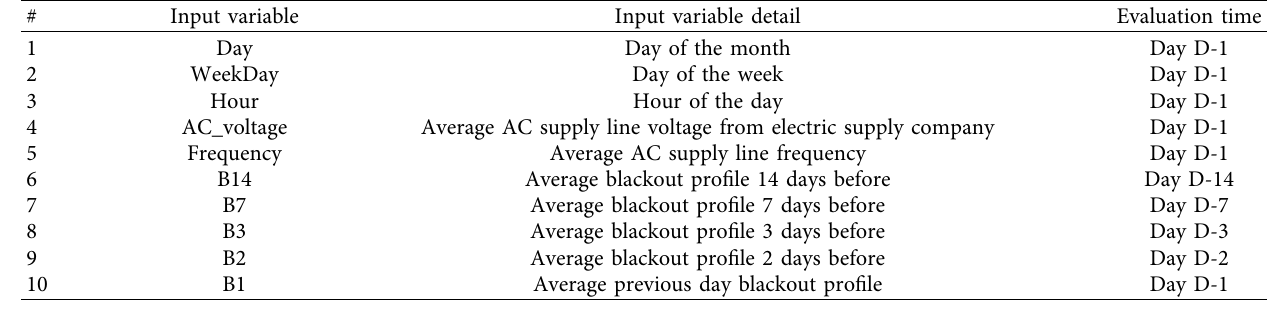
Figure 2: Proposed power outage prediction approach. Table 1: Input features details.